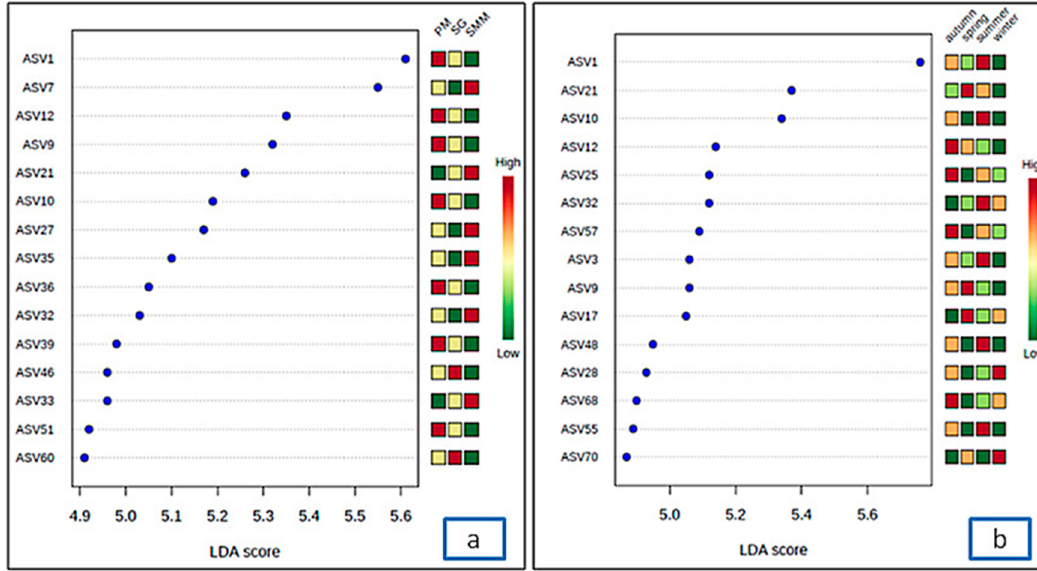
Figure 7. Characterization of SAMCs in different sampling sites ( a ) and sampling periods ( b ) by LEfSe analysis and LDA. Diagram of the LDA scores (log 10 ) computed for the highest 15 abundant ASVs at different sites and sampling periods. SMM: Santa Maria del Mare, PM: Porto Marghera, and SG: San Giuliano.